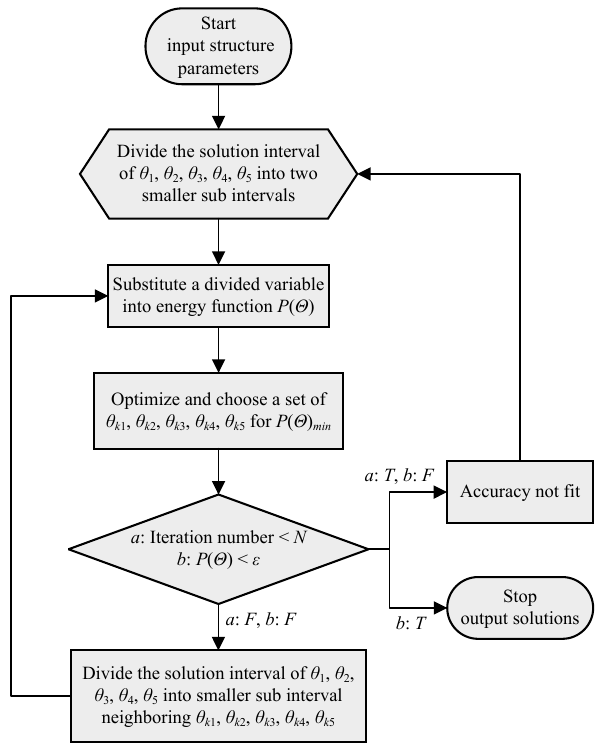
Figure 6. Flow chart for numerical solution of the proposed inverse